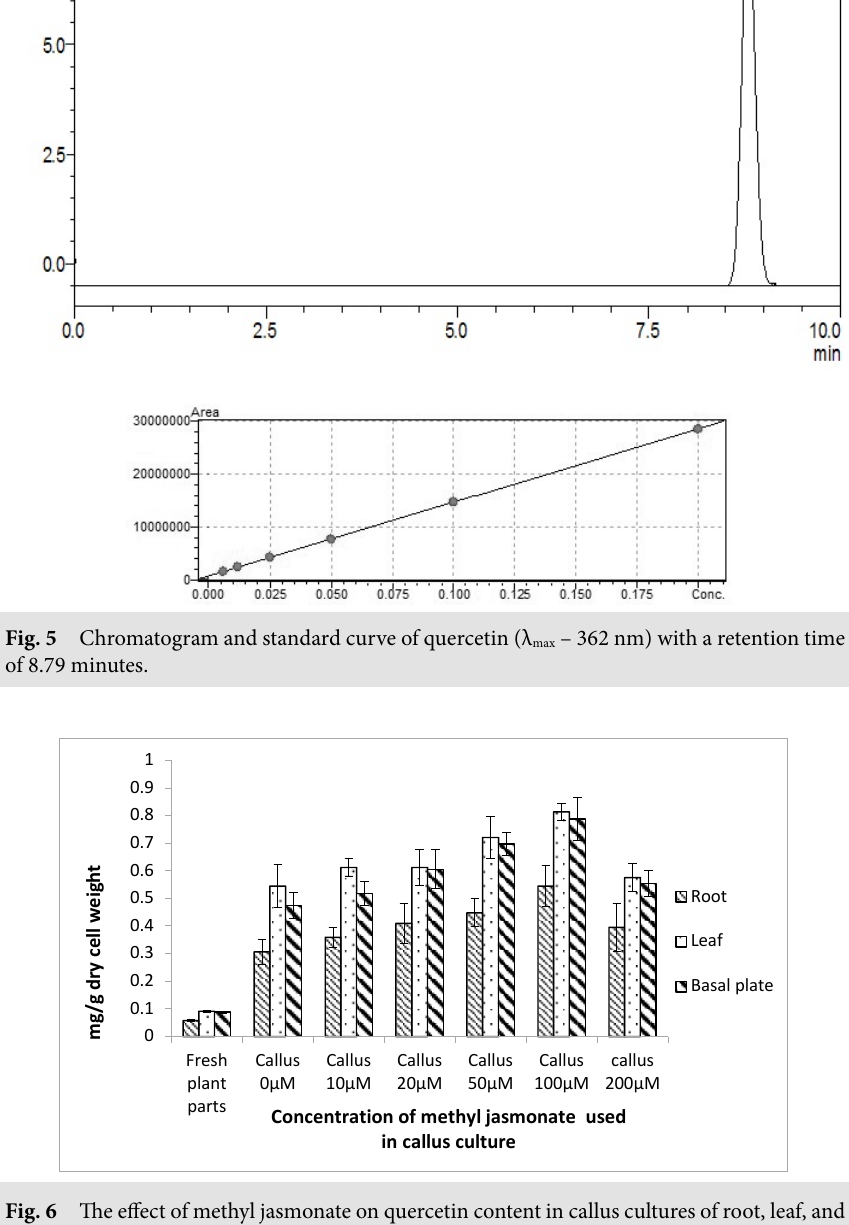
Fig. 6 The effect of methyl jasmonate on quercetin content in callus cultures of root, leaf, and basal plate tissues of A. cepa . Two-way ANOVA showed significant ( p < 0.05) variation between quercetin content of plant parts and different concentrations of methyl jasmonate